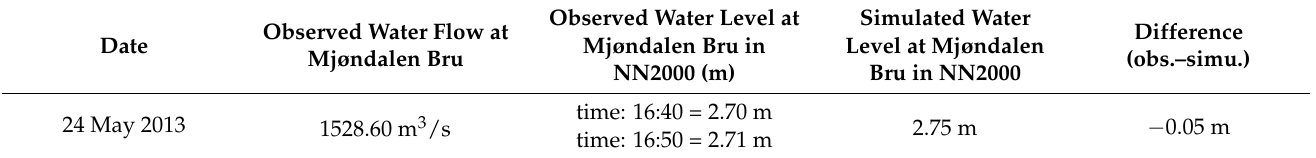
Table 4. Simulated and observed water levels for Drammenselva at measuring station Mjøndalen bridge